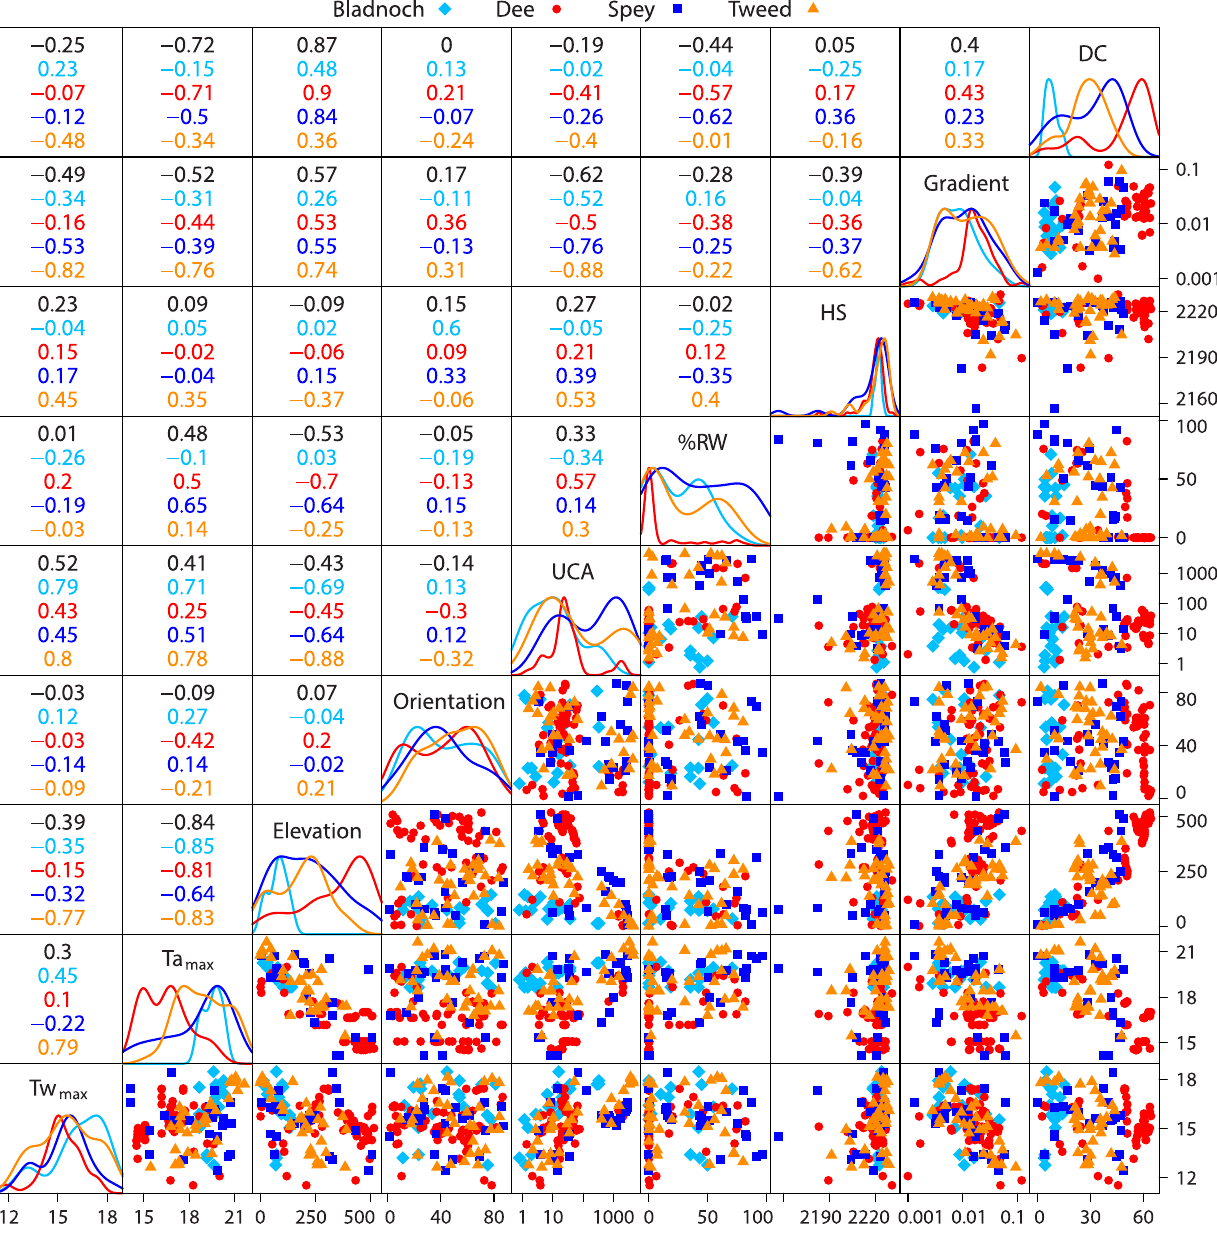
Figure 2. Distributions and inter-relationships between T w and covariates. Scatter plots of the relationships are shown below the diagonal, max kernel density plots of the individual covariates in the diagonal (scaled to have the same maximum value) and correlation coefficients above the diagonal. Numbers in black indicate the correlation coefficients where data are pooled across all